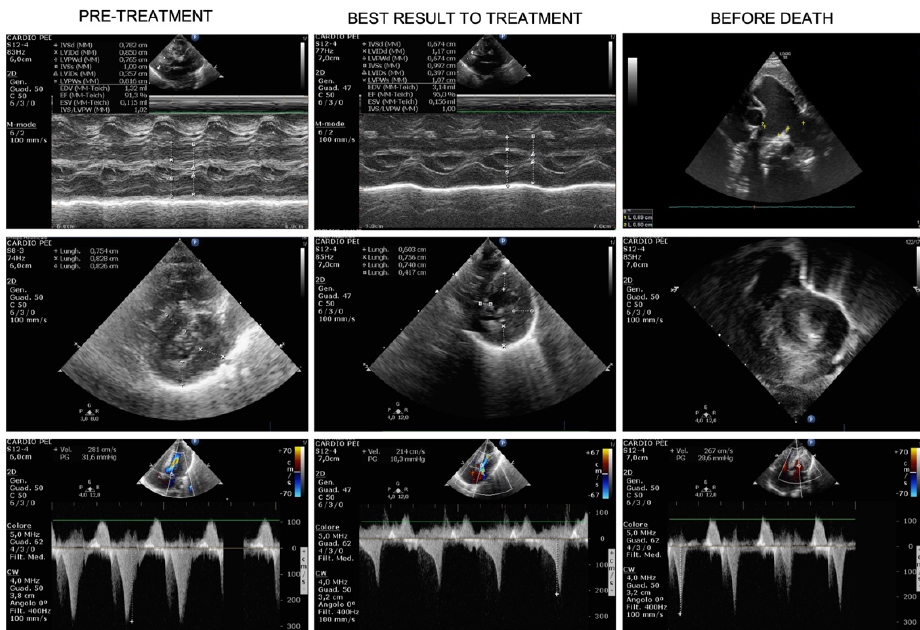
Figure 2. Evolution over time of hypertrophic cardiomyopathy (HCM). Pre-treatment US (first column) shows severe HCM at M-mode Left Ventricle (Mm-LV, first row), short-axis LV (second row) and LV outflow track obstruction (CW-Doppler, third row), few days before treatment start. The best result under treatment is shown in the middle column: Mm-LV in first row, short-axis LV (second row) and LV outflow track obstruction (third row) demonstrated a consistent reduction of LV thickness and improvement of LV outflow track obstruction. The third column shows cardiac US three days before death: pulmonary artery dilatation is evident in the first row (2D), the rapid worsening of HCM, both in terms of LV thickness and obstruction are depicted in the last 2 rows (short-axis LV and CW-Doppler, respectively).